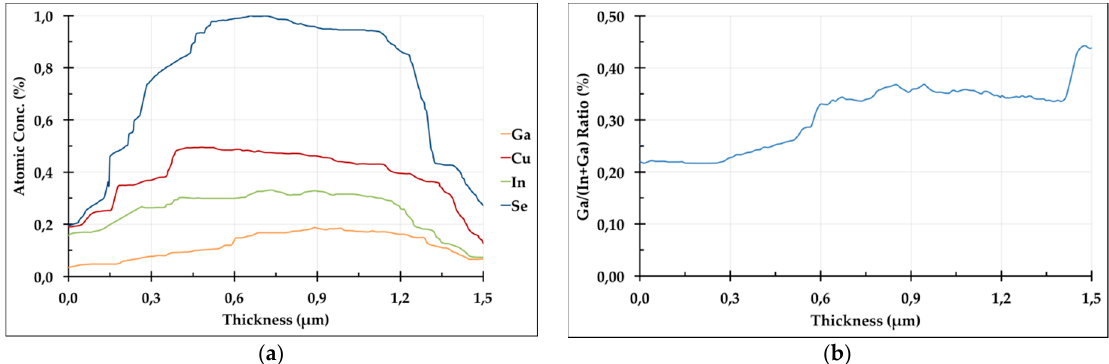
Figure 5. ( a ) Secondary ion mass spectroscopy (SINS) in ‐ depth profile spectrum of the CIGS layer, after selenization of In 2 Se 3 –Ga 2 Se 3 –Cu stacked layers. To make the spectrum more legible, the Mo signal was removed; ( b ) detail of the Ga/(In+Ga) ratio along the CIGS layer thickness.